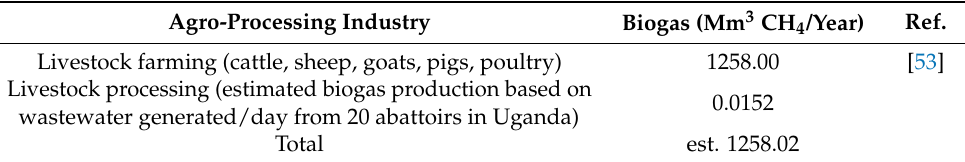
Table 3. Theoretical biogas potential from livestock industry in Uganda. Agro-Processing